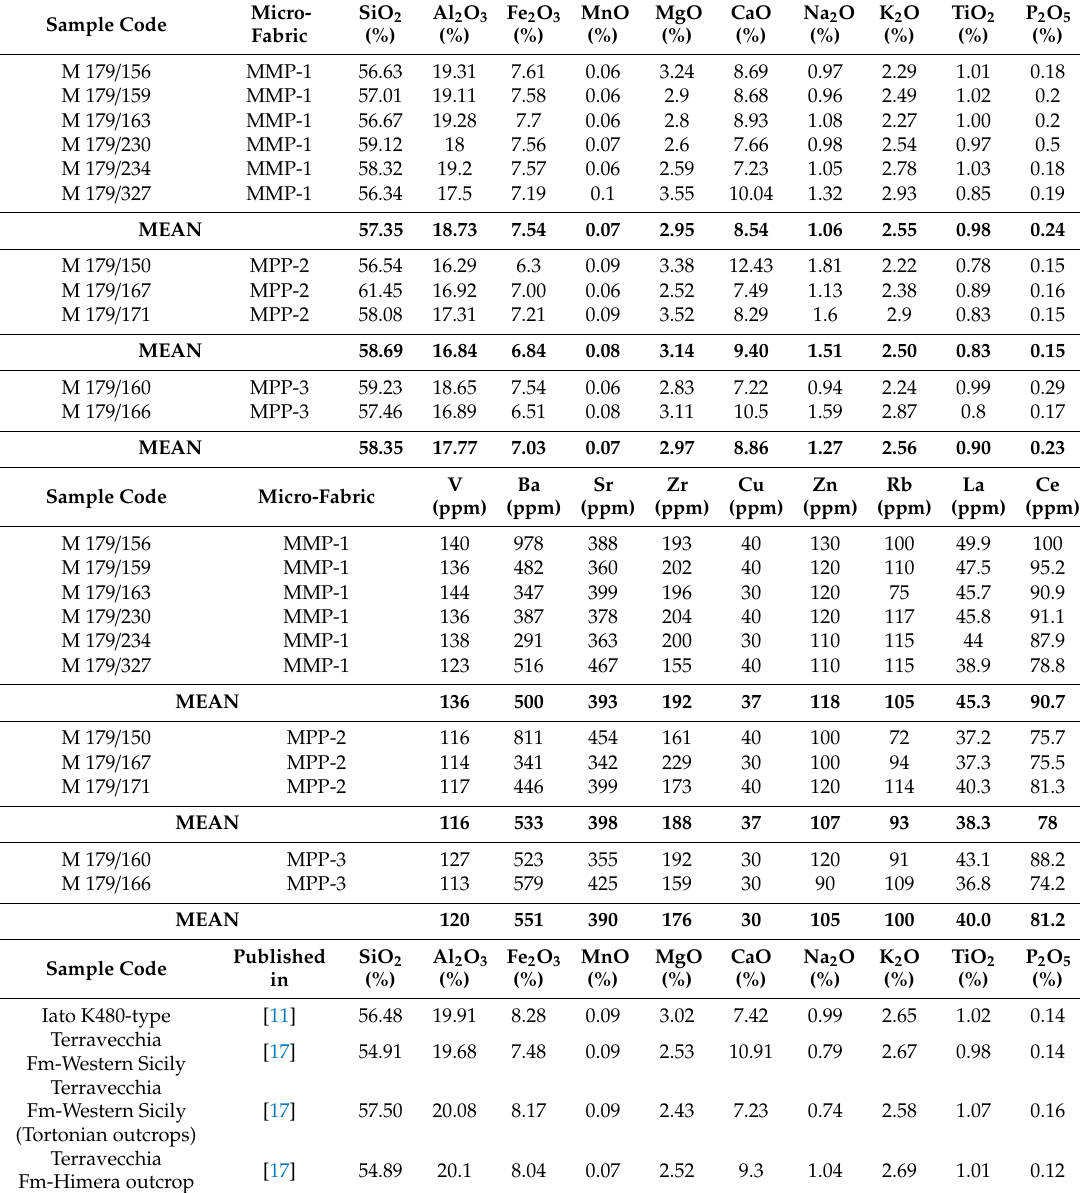
Table 3. LOI normalized chemical composition of the studied western Greek